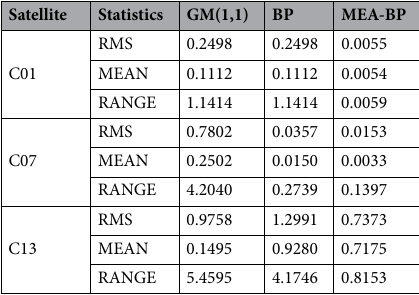
Table 1. Statistics of 2-h prediction results of three satellites (unit: ns).